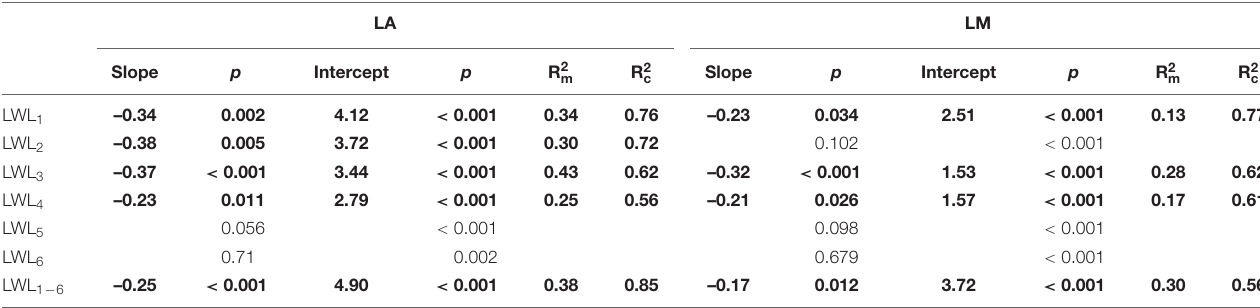
TABLE 3 | Relationships between leaf size (individual leaf area, LA and individual leaf mass, LM) and leaf water loss from 1 h (LWL 1 ) to 6 h (LWL 6 ; n = 3), analyzed using linear mixed models with LA and LM as the mixed factor and tree species as the random factor. LA